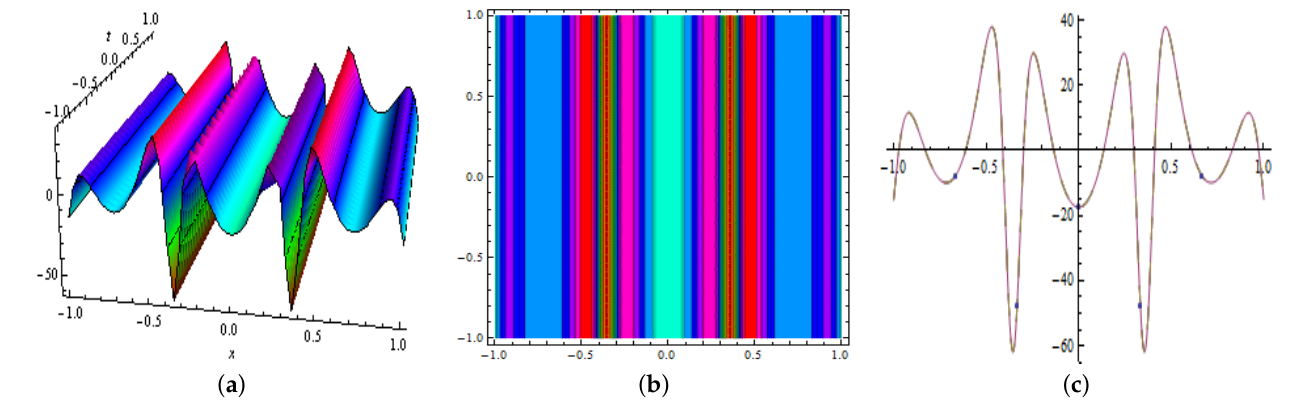
( b ) ( c ) Figure 6. explain three-dimensions in ( a ); contour in ( b ) and two-dimensions in ( c ), Plots of n 36 ( x , t ) in Equation (30) for a = 0.3, u 0 = 0.8, b 4 = 2, b 5 = − 5, b 7 = − 3, c = 0.4, α = 0.8,